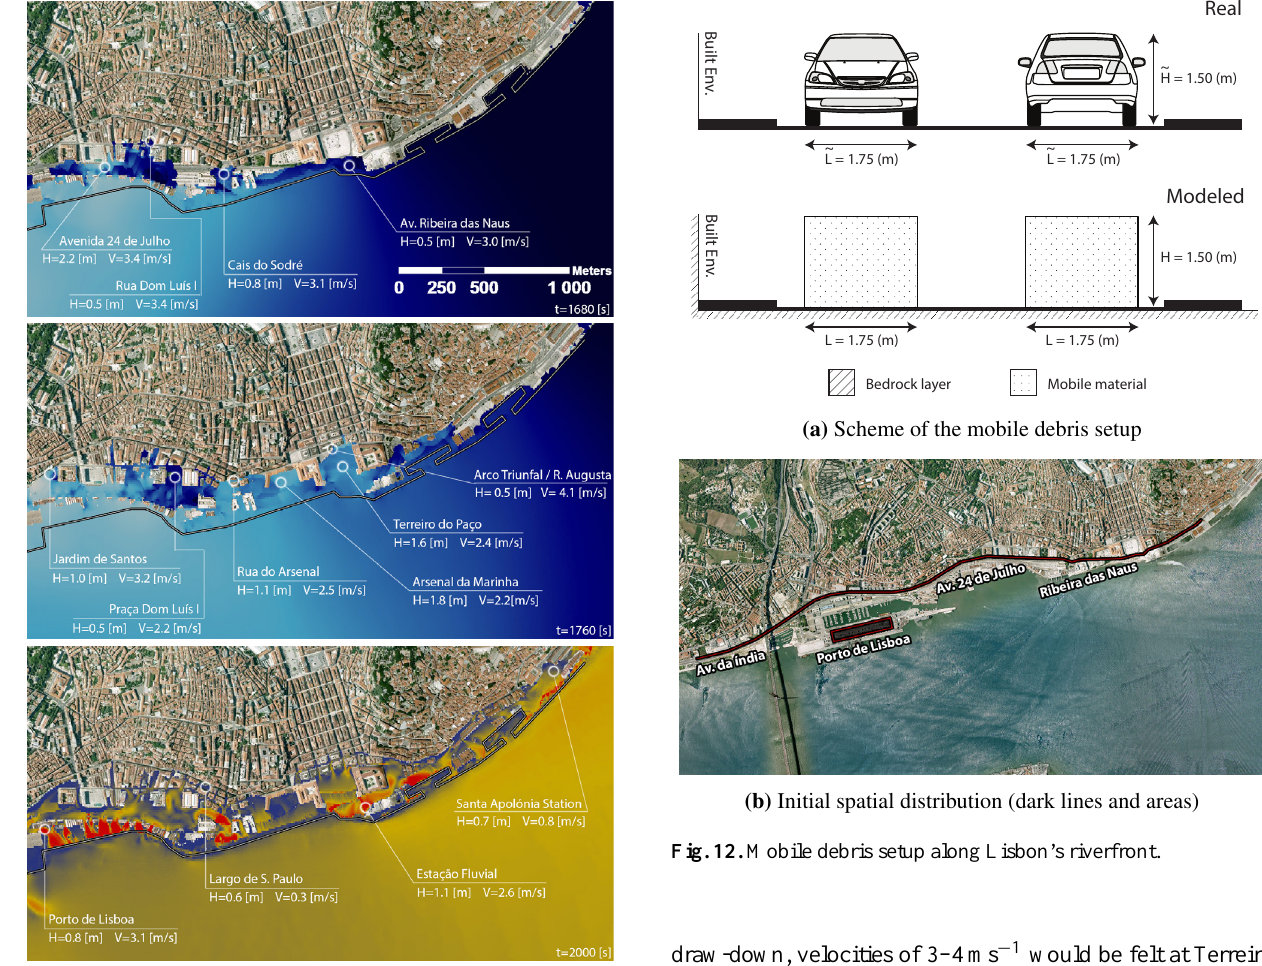
(Ferreira et al., 2009) was employed when modeling solid 350 transport and a layer of mobile material was added to the base DEM, which was held immobile during this simulation.